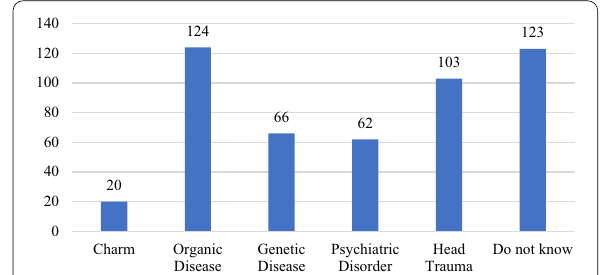
Fig. 1 Causes of migraine as perceived by the population of the study